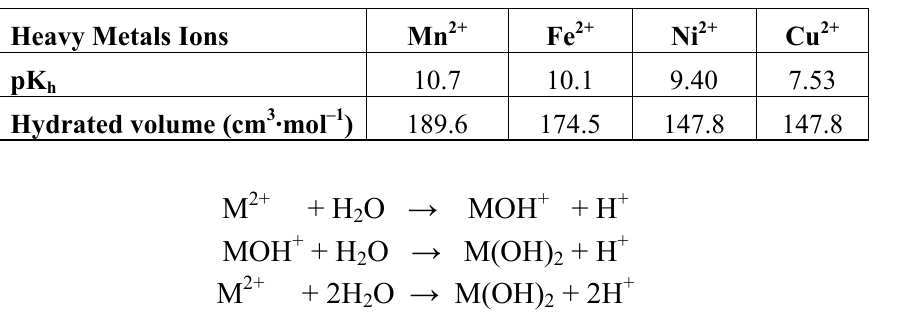
Table 3. Hydrolysis constants and ionic volumes of metals